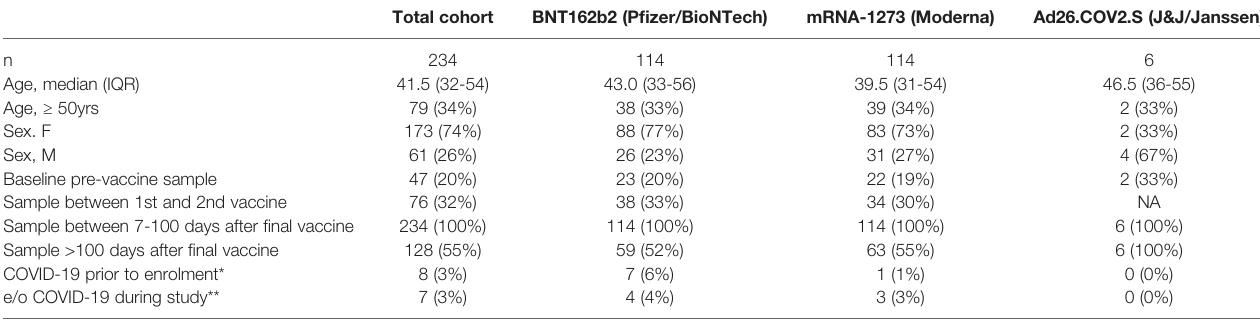
TABLE 1 | Characteristics of Vaccinated Study